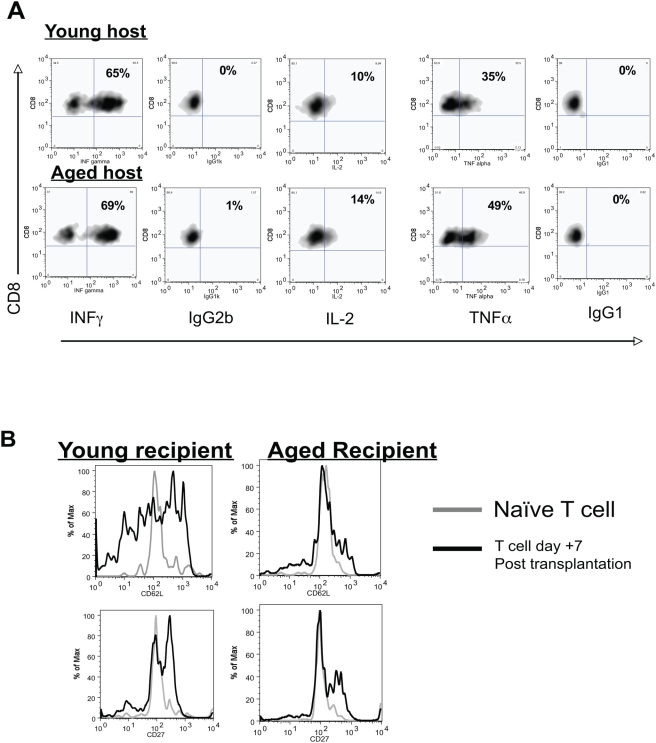
Transplant specific CD8+ T cells produced similar cytokine profiles but impaired activation in aged transplant recipients as compared to young recipients.A: Representative flow cytometric plots on day +7 post transplantation are shown along with isotype controls (IgG2b for IFNγ, IgG1 for IL-2 and TNFα). Young antigen specific CD8+ T cells produced similar amounts of TNFα, IL-2 and IFN-γ during ex vivo culture with OVA peptide regardless of the age of the recipient environment (cytokines were not produced if peptide was not added, data not shown). Proportions are shown in right upper quadrant. Note, that cytokines were not detected in either aged or young mice that were adoptively transferred but did not receive an OVA expressing skin transplant (data not shown). Similar results were noted at day +14 post transplantation (data not shown). Flow cytometric plots are gated on CD45.1+ cells. N = 3/group, representative data from three independent experiments with consistent results. B: Representative flow cytometric plots of adoptively transferred CD45.1+, OTI young T cells on day +7 post transplantation. Young antigen specific CD8+ T cells upregulated CD27 and downregulated CD62L to a greater degree in young transplant recipients compared to antigen specific CD8+ T cells in aged transplant recipients.